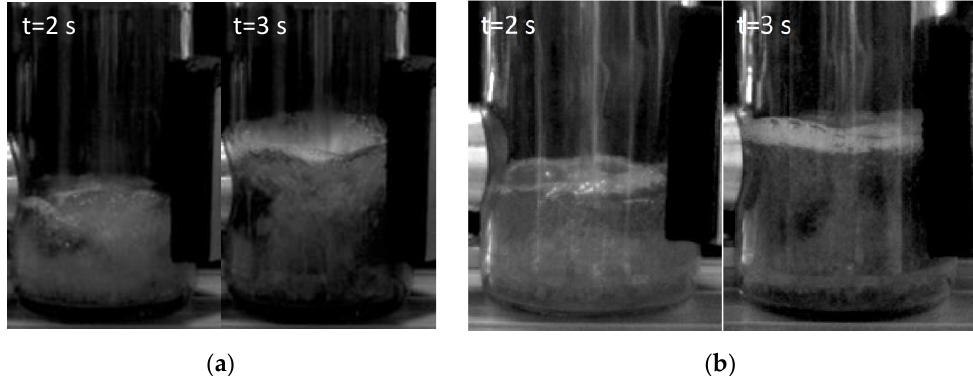
Figure 6. Bubble-free regions during filling time events t = 2 s and t = 3 s for apple juice at 45 kHz, 15 W ( a ) and unchanged bubble distribution without ultrasound ( b ).